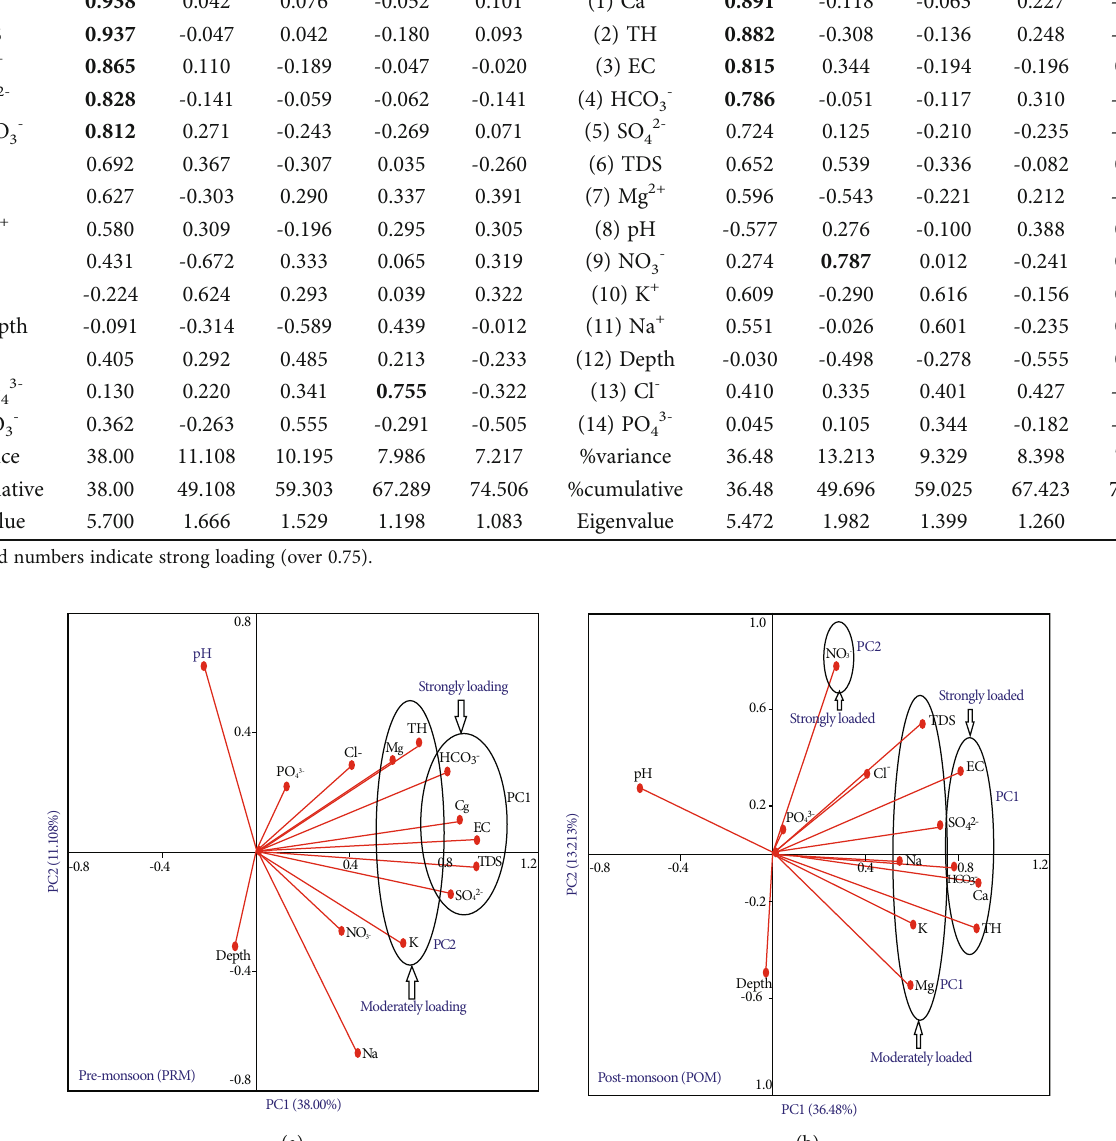
Table 4: Principal component (5 components extracted) loadings of the analyzed parameters in the study areas (sorted by size). Parameter